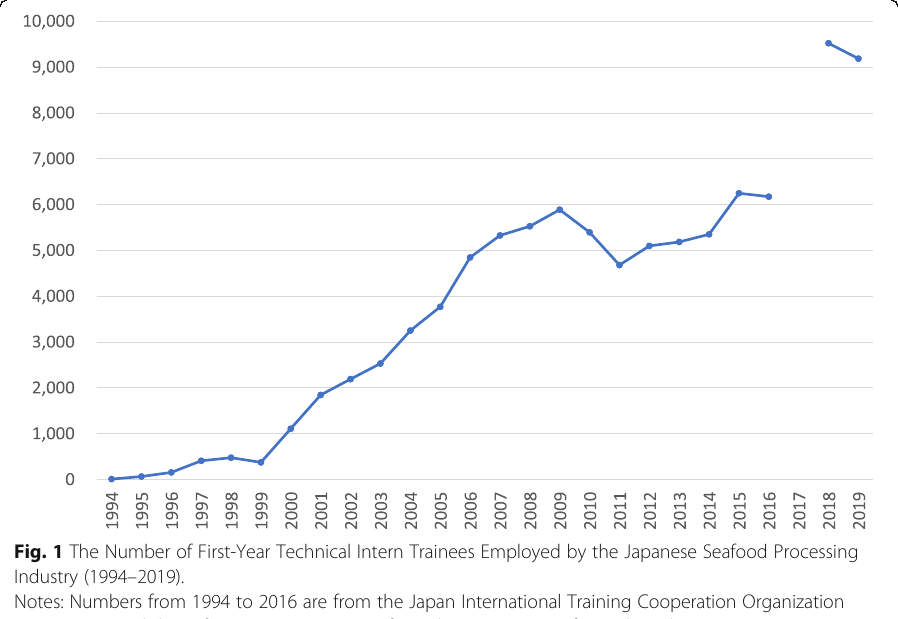
Fig. 1 The Number of First-Year Technical Intern Trainees Employed by the Japanese Seafood Processing Industry (1994 – 2019). Notes: Numbers from 1994 to 2016 are from the Japan International Training Cooperation Organization (2000-2018), and those from 2018 to 2019 are from the Organization for Technical Intern Training (2019- 2020). Owing to different counting methods, data from these two sources are not directly comparable. A number for 2017 is not shown because complete data are not